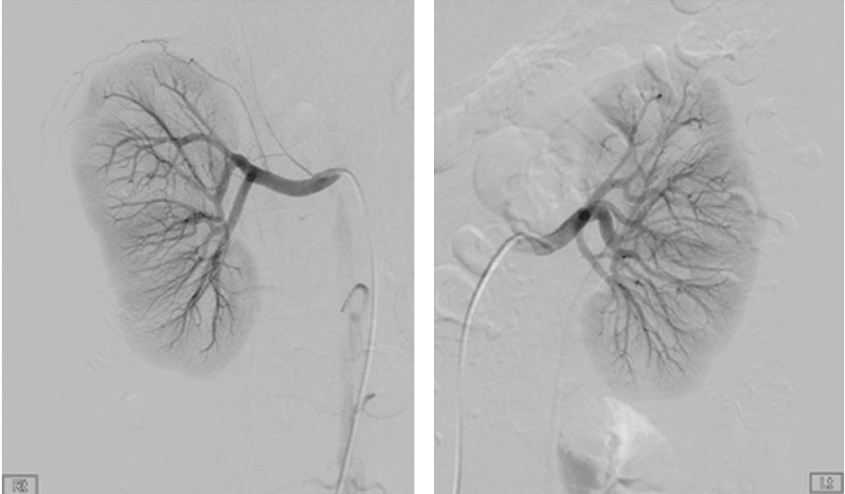
Figure 2: Conventional renal angiography. Renal angiography showed to multiple small aneurysms at the arcuate artery of both renal arteries.